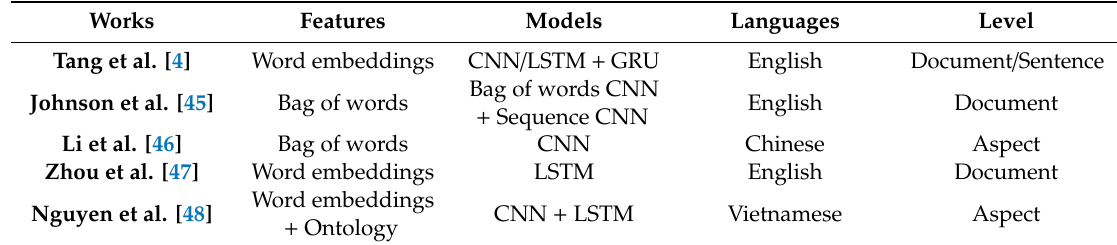
Table 2. Examples of new researches on sentiment classification using deep learning.